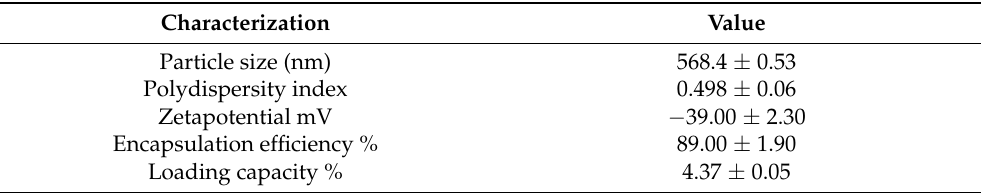
Figure 2. ( A ) Particle size distribution measured by dynamic laser light scattering (DLS) technique. ( B ) Scanning electron micrograph shows uniform and spherical shape of C. speciosus extract-loaded nanostructured lipid carriers (CSE-NLCs) with no evident signs of aggregation. Table 2. Summary of characterization of C. speciosus Extract Loaded Nanostructured Lipid Carriers